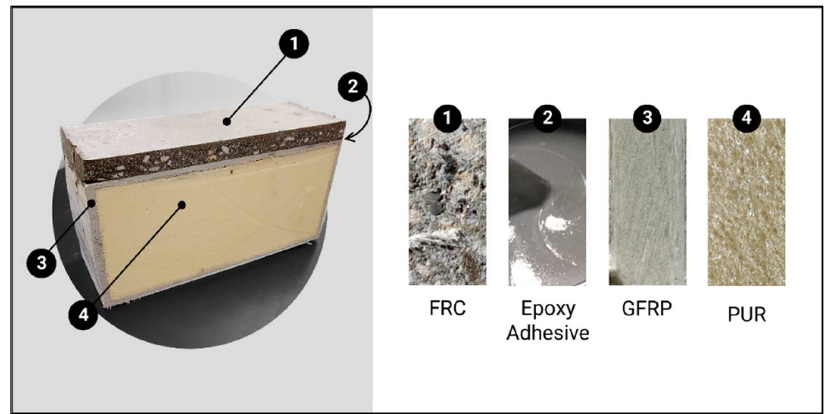
Figure 1. Photo of the hybrid sandwich panel and constituent materials.